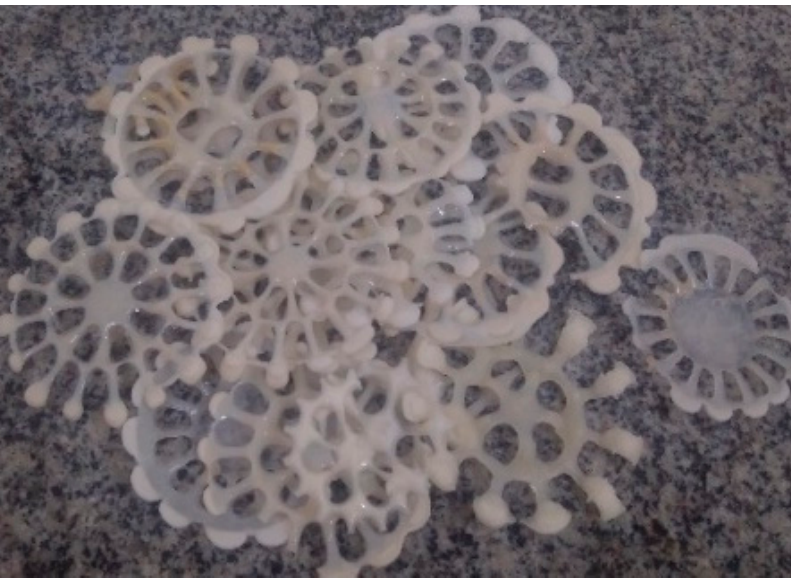
Figure 2. PMMA based dental resins in form of rosettes, discharged by the quality production process control, were used as raw material by depolymerization at 345, 405, and 420 °C, atmospheric pressure, in pilot scale.